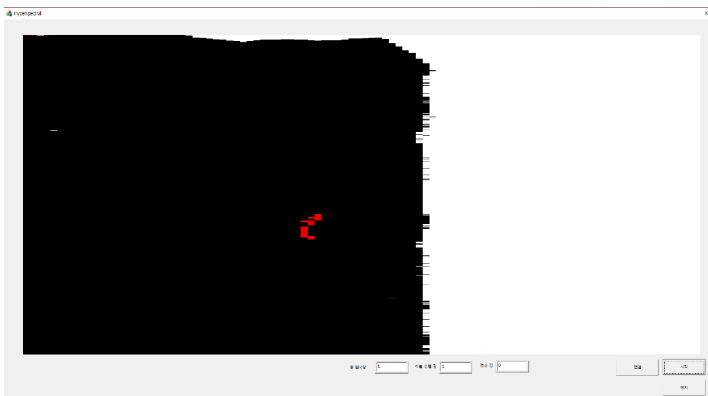
Figure 13. Foreign object detection platform.